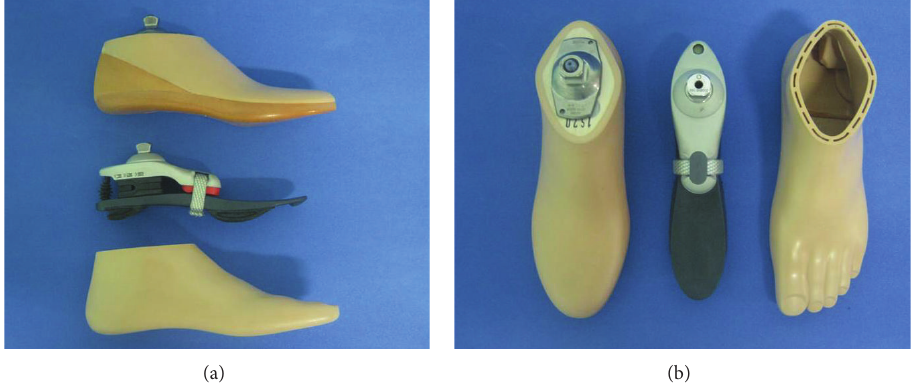
Figure 1: The SACH and the 1M10 Adjust prosthetic feet on the sagittal (a) and the transversal (b) plane. The SACH foot is placed on the top in (a) and on the left in (b), while the 1M10 Adjust is depicted with the respective cosmetic